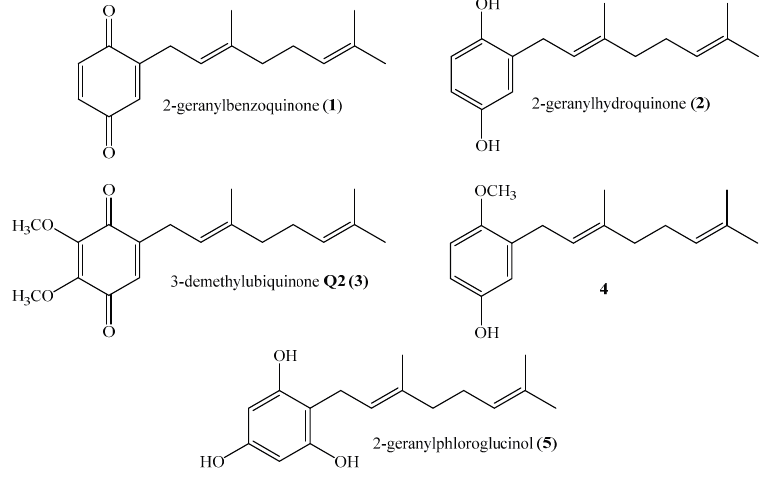
Figure 1. Structures of some active linear